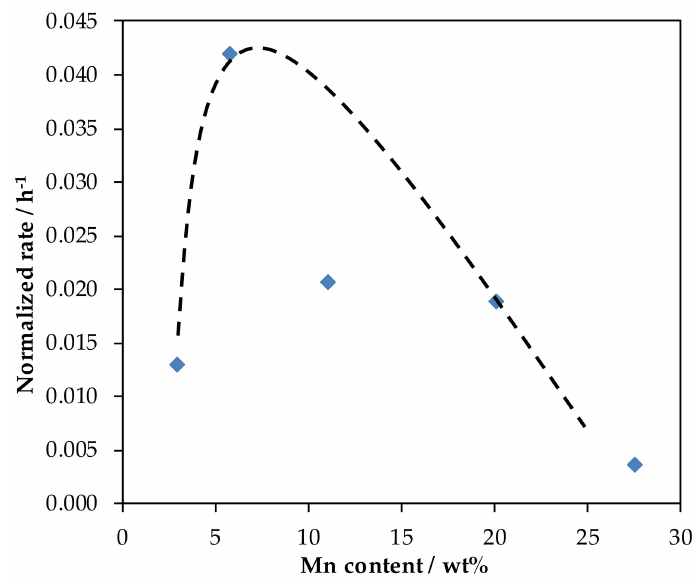
Figure 6. Normalized rate as a function of the Mn content (wt%).